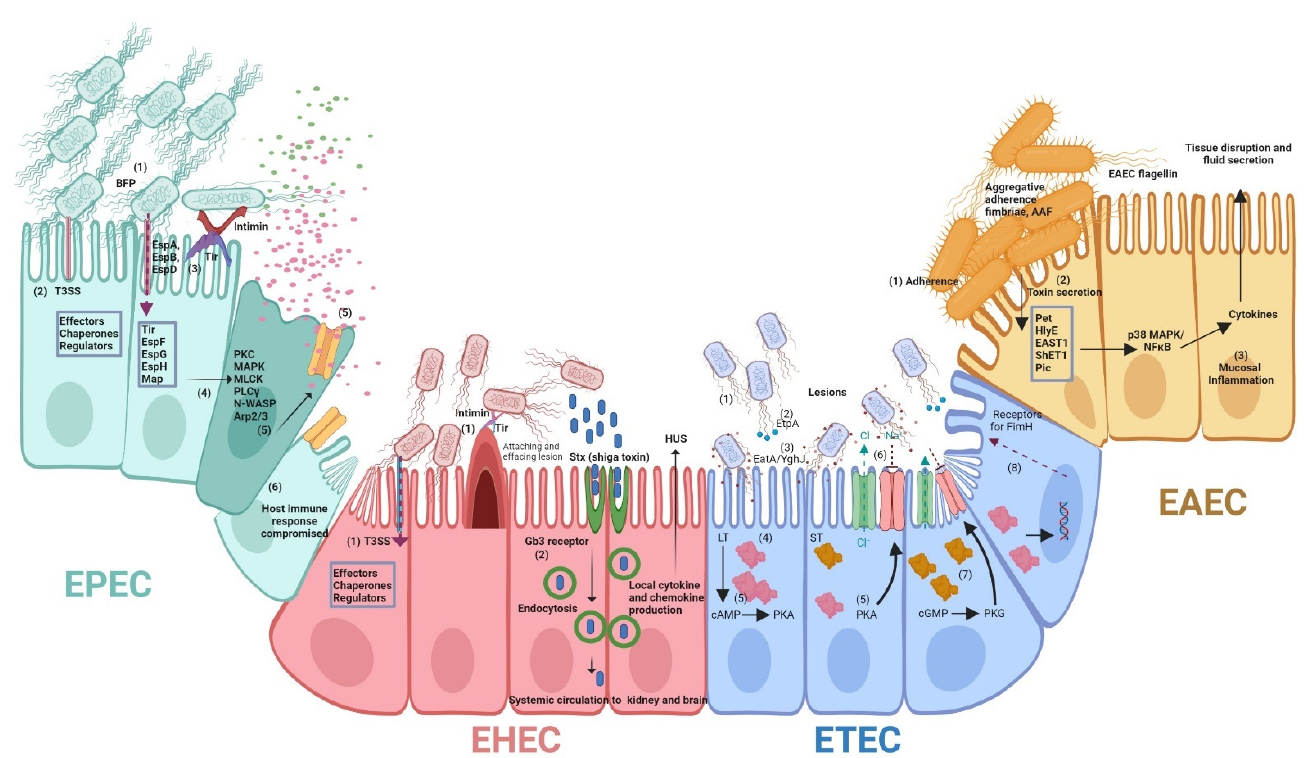
Figure 1. Combined pathogenesis of EPEC, EHEC, ETEC and EAEC. EPEC (Gray) is famous for production of lesions known as “Attaching and effacing (A/E)” lesions that are produced when bacteria intimately attach to intestinal epithelial cells. Bundle-forming pilus (BFP) helps in interbacterial adherence as well as adherence to epithelial cells (1). Pathogens contact the host cell via T3SS and its effectors (2). The intimate attachment of bacteria with the epithelial cells is mediated by the Tir-EspA-EspB-EspD complex into the host membrane and intimin on the bacterial membrane (3). The type III secretion system releases various effector proteins—including Tir, EspF, EspG, EspH and MAP are migrated in the cytoplasm (4) where it interacts with host proteins such as N-WASP and the Arp2/3 complex to cause actin rearrangement and the pedestal formation. Protein kinase C (PKC), phospholipase C γ , myosin light-chain kinase and mitogen-activated protein (MAP) kinases are triggered. These multiple complex effacements lead to increase intestinal inflammation, intestinal permeability, and loss of absorptive surface area (5,6). EHEC (Red) is also attaching and effacing (A/E) pathogens that efface the microvilli and subvert host cell actin to form pedestals beneath the attachment site, but the mechanism is slightly different from EPEC, Tir is not phosphorylated. EHEC injects effector proteins such as Tir and EspFu into the host cytoplasm through the T3SS (1) and Tir binds to intimin to attach the bacteria to the host cell (1). Tir and EspFu recruit host factors to subvert host cytoskeleton and actin polymerization. In addition, Shiga toxin (Stx; also known as verocytotoxin) is released in response to stress, further contributing to disease. The B subunit of Stx toxin binds to the glycosphingolipid globotriaosylceramide (Gb3), present in lipid rafts on the surface of the target cell and is internalized (endocytosis) (2), and the Shiga toxin is activated through cleavage of the A subunit into two fragments by the protease furin. Stx toxin, if absorbed into the systemic circulation, can cause direct endothelial injury by increasing inflammation, inducing expression of cytokines and chemokines, and even can damage important organs, especially the kidney and the brain. ETEC (Blue) strains adhere to intestinal epithelial cells with the help of one or more peritrichous flagella or fibrillar colonization factors (CFs) (1). EtpA mediates the bridging of flagella with glycan receptors present in mucin (2). Mucinolytic serine protease EatA helps to degrade MUC2, the major mucin secreted by goblet cells, while YghJ is required for efficient access to the surfaces of enterocytes (3) providing bacterial access to the epithelial surface. Coincident with these events, the bacteria deliver pre-formed LT and ST to their respective receptors on the host